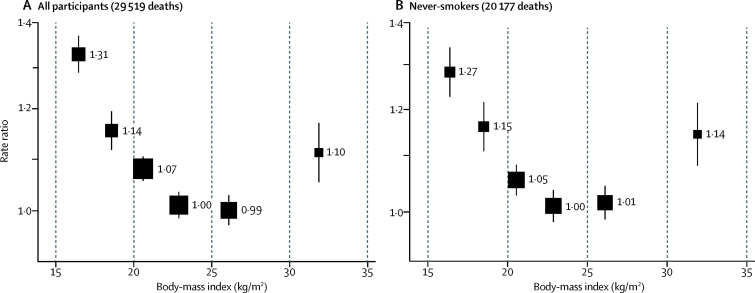
Body-mass index vs all-cause mortality at ages 35–69 years in Chennai, India, among all participants (A) and lifelong never-smokers (B)Rate ratios were adjusted for major confounders (age, sex, education, socioeconomic status, alcohol, and smoking [when appropriate]), and omitted the first 2 years of follow-up. Exclusions are as per table 1. For each body-mass index category, the area of the square is inversely proportional to the variance of the category-specific log risk, which also determines the 95% CI (represented by error bars).